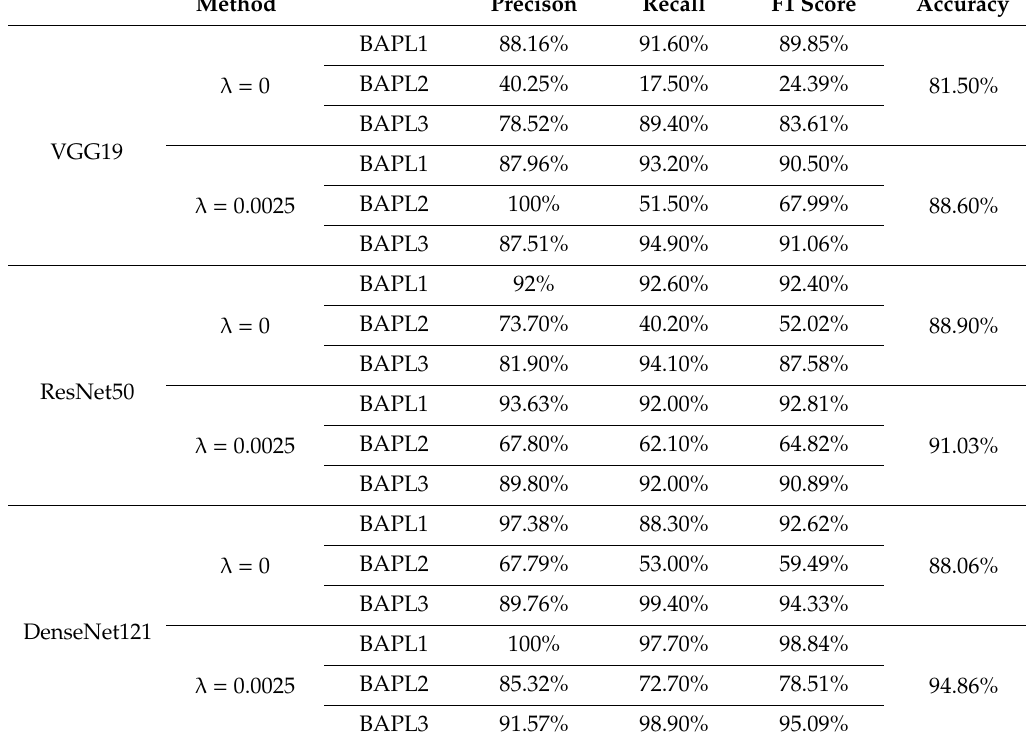
Table 6. Comparison of classification performances between the proposed joint loss function and the conventional loss function in the three network architectures.